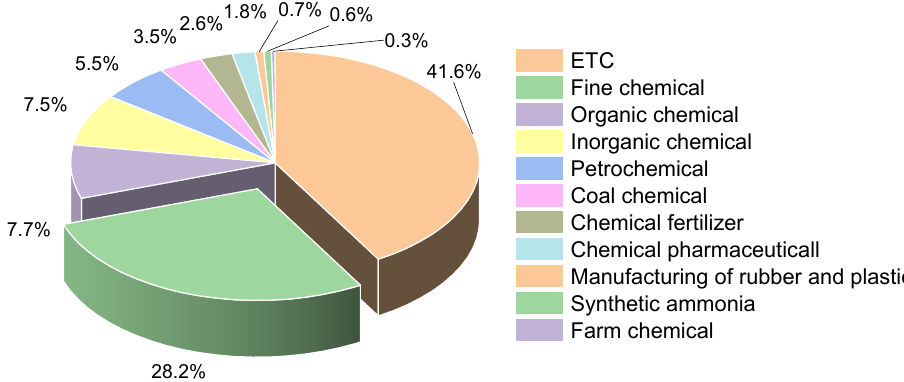
Figure 7. The percentage of casualties in different industries from 2000 to 2020.